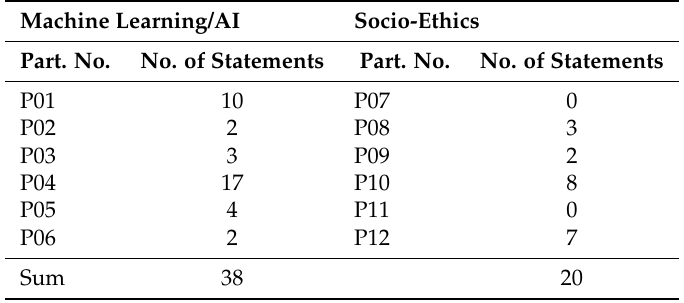
Table 4. Number of statements per interviewee related to